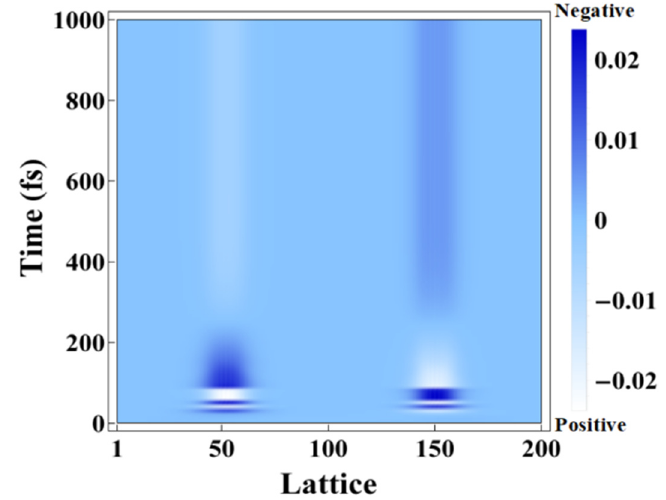
Figure 6. ( a – f ) Evolution of the charge density distribution along the poly(p-phenylene vinylene) (PPV) polymer chain by an external laser of 70 µJ/cm 2 at 0 fs, 10 fs, 20 fs, 30 fs, 40 fs, and 1 ps.